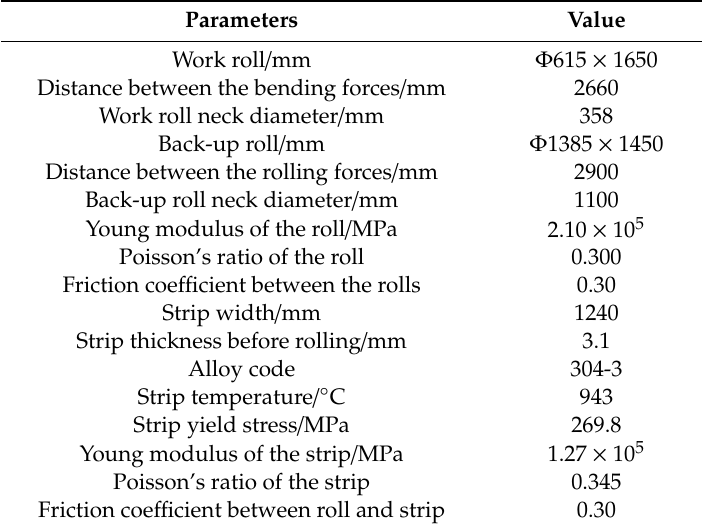
Table 1. Parameters of the geometrical dimension and the material.